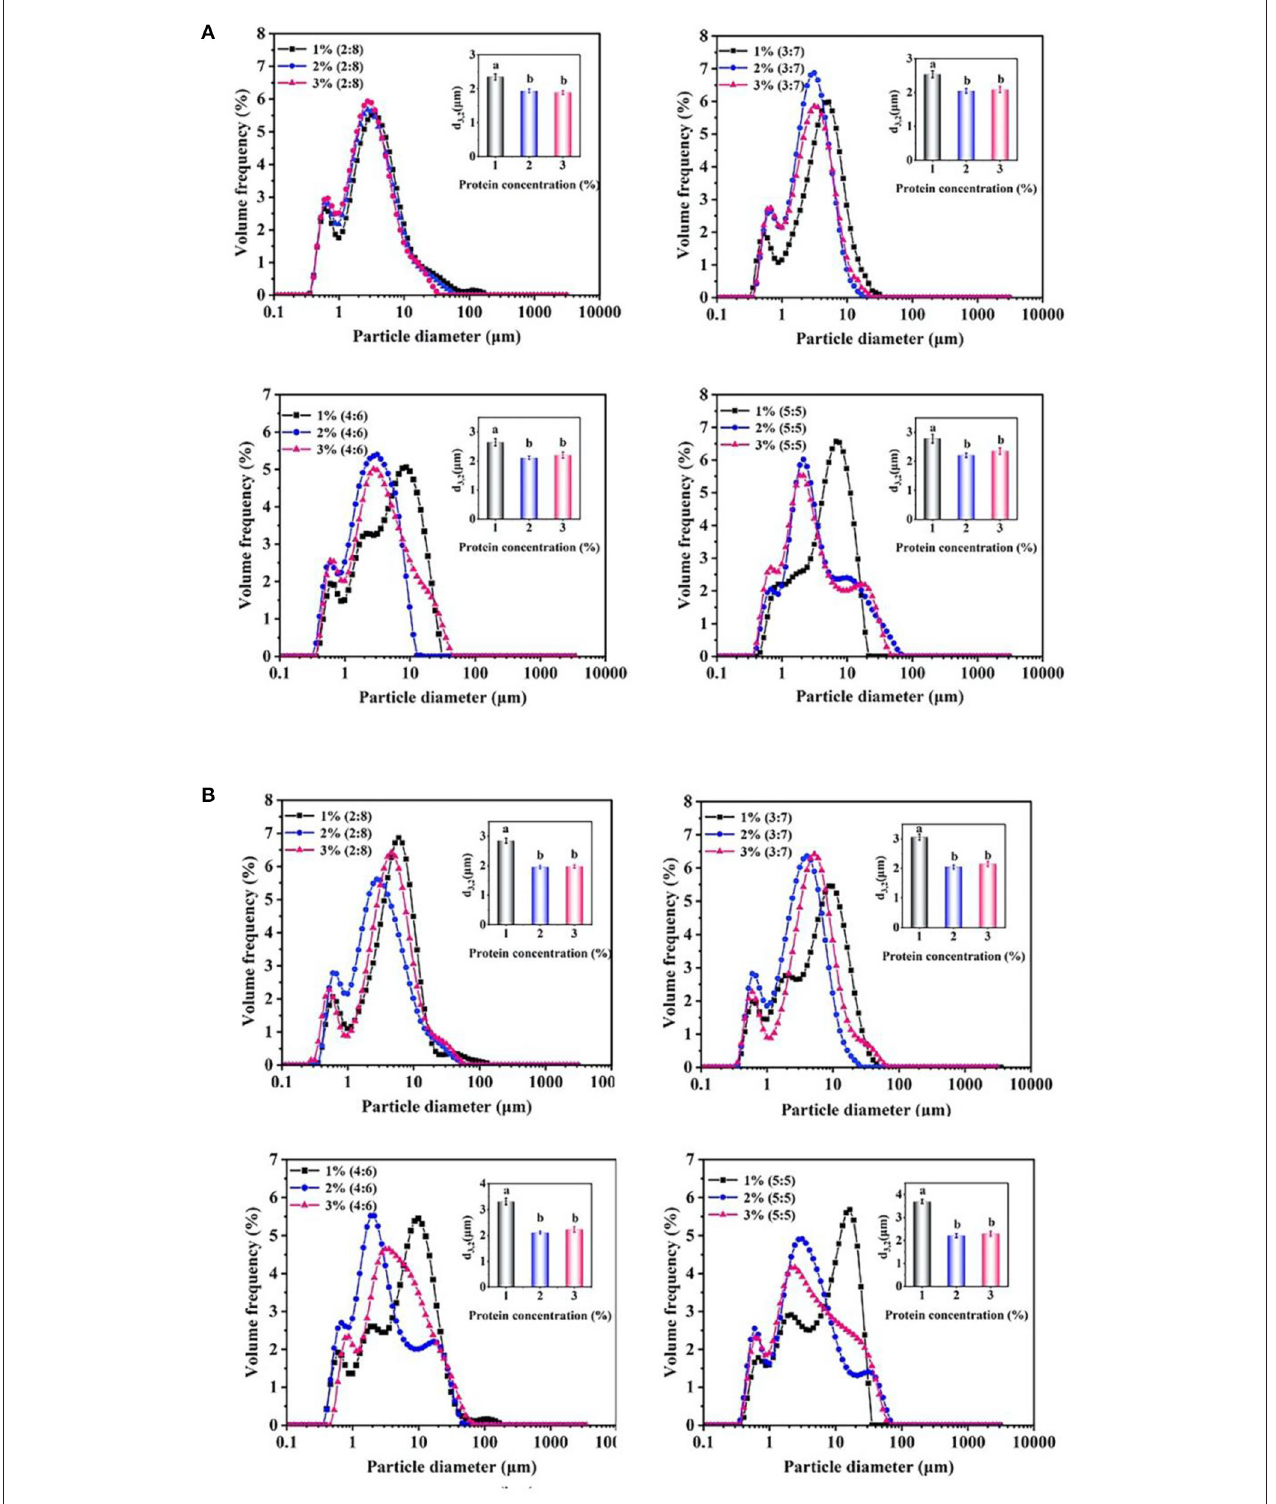
FIGURE 3 | Droplet size changes of the proteins-stabilized emulsions after 0 days (A) and 30 days (B) . Mean values followed by different letters are significantly different ( P < 0.05).